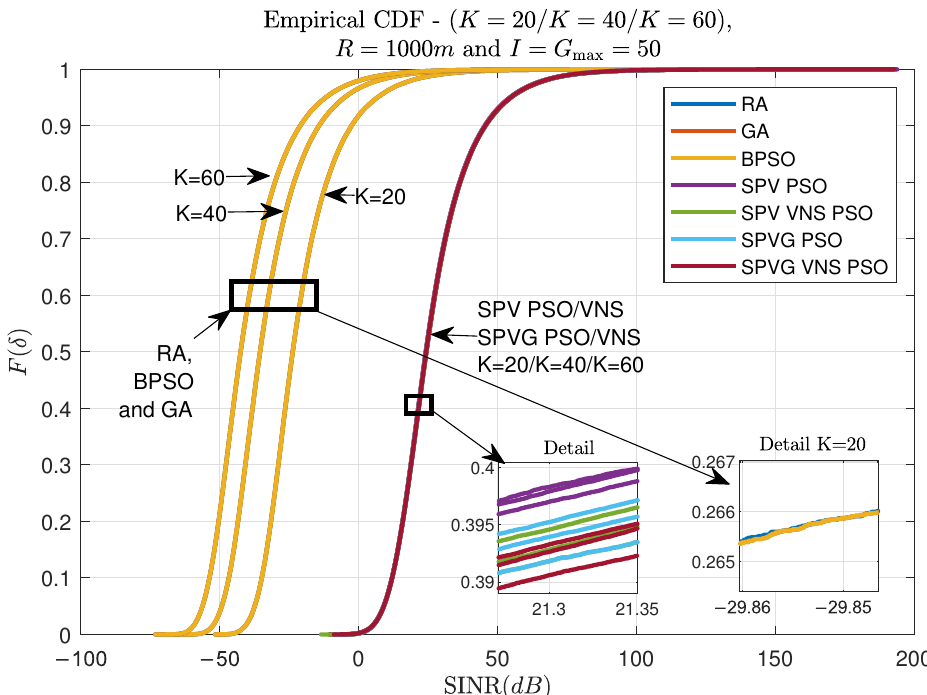
Figure 9. Empirical CDF for K = 20, K = 40 and K = 60 users in an R = 1000 m cell size scenario with the maximum number for iterations set to 50 for all